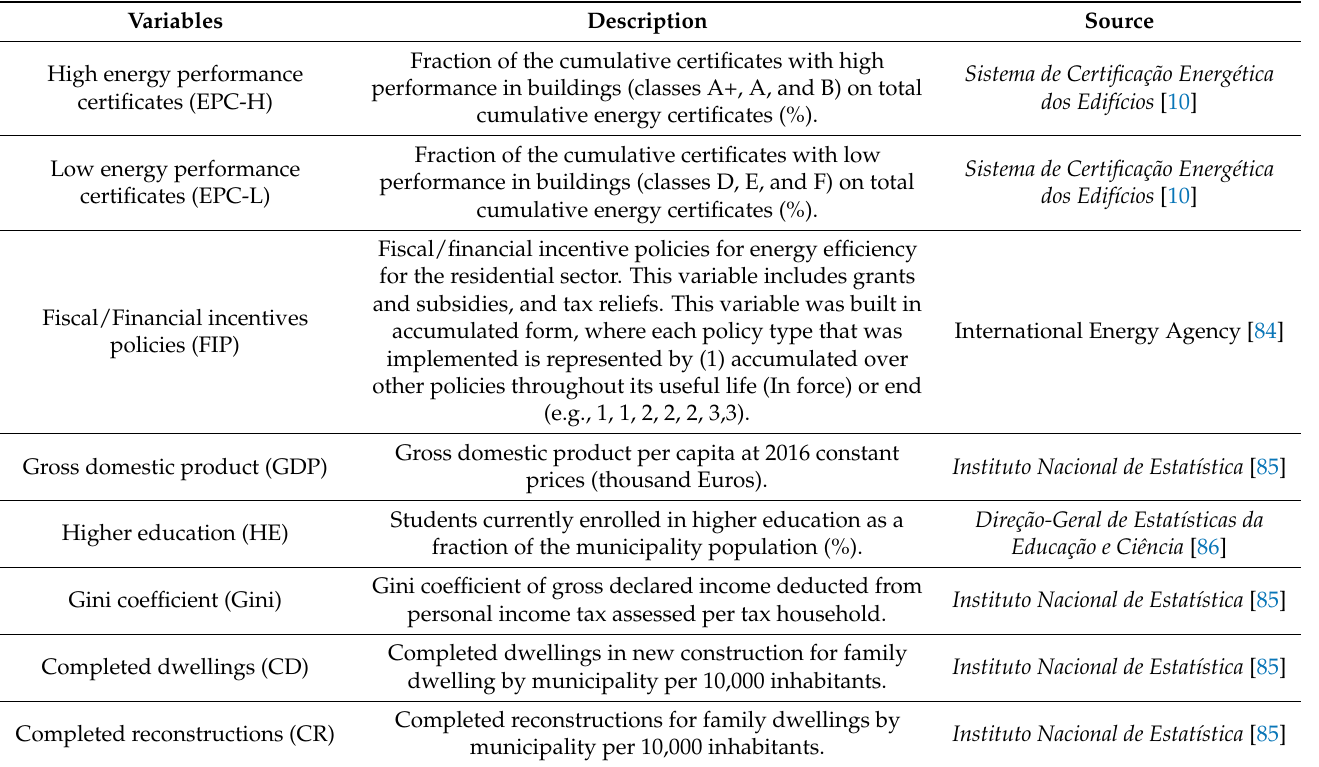
Table 2. Description of the variables.